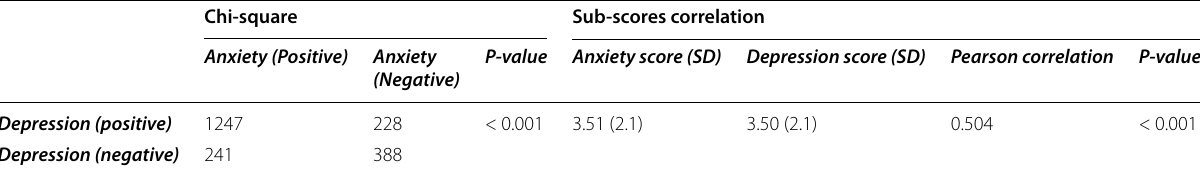
Table 5 Association between anxiety and depression subscales using crosstabs and Pearson correlation ( n